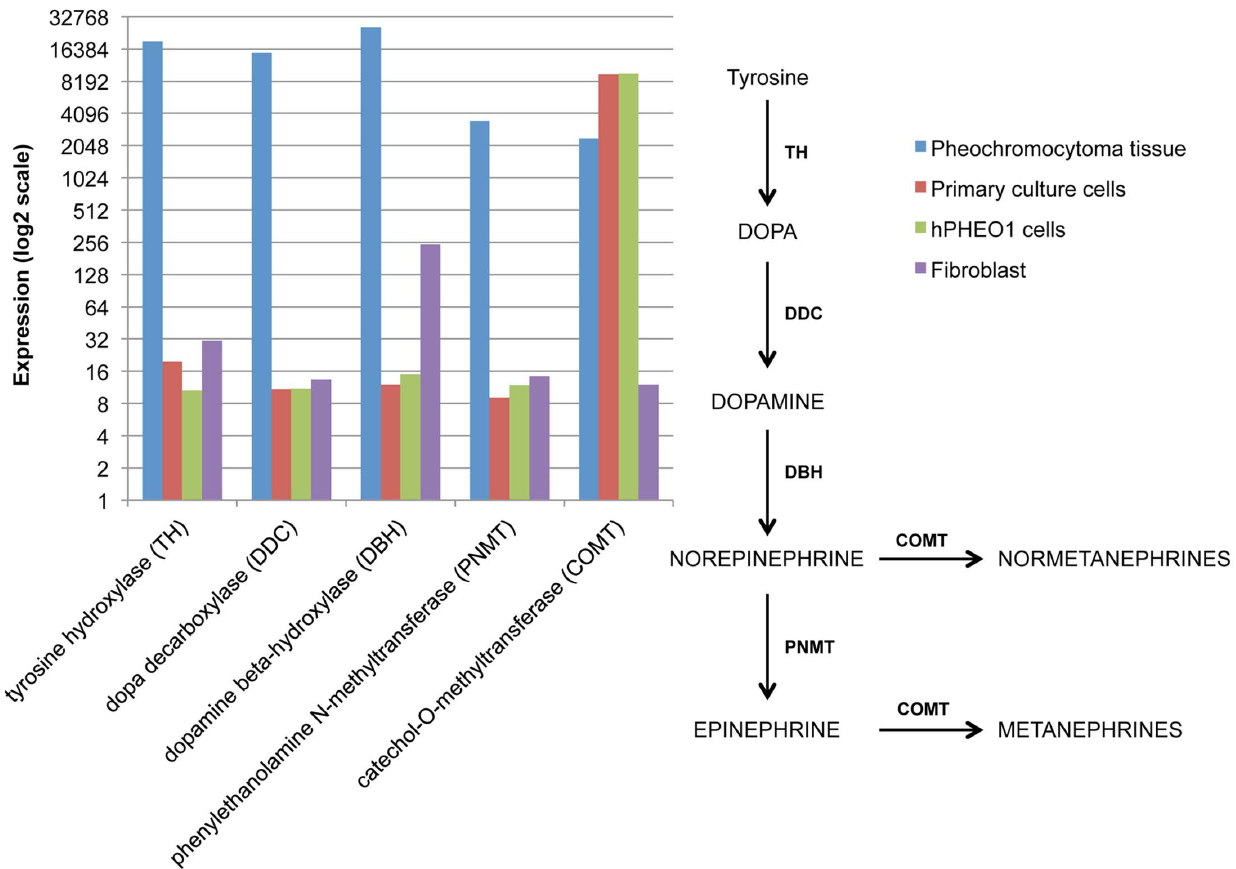
Figure 4. RNA expression of catecholamine enzyme synthesis. Enzyme expression for catecholamine synthesis is down-regulated in hPheo1 cells, however COMT expression is increased.